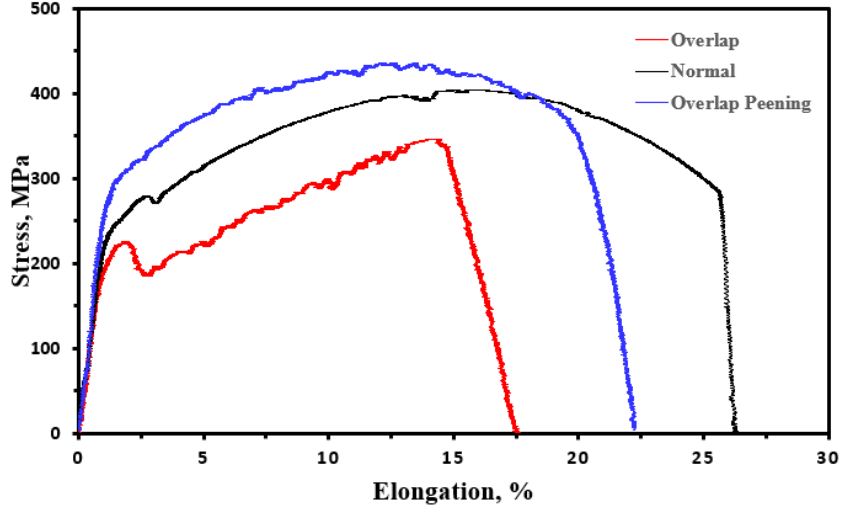
Figure 8. Stress–strain curves of welded specimens with a normal weld, overlap defect, and overlap defect after peening.